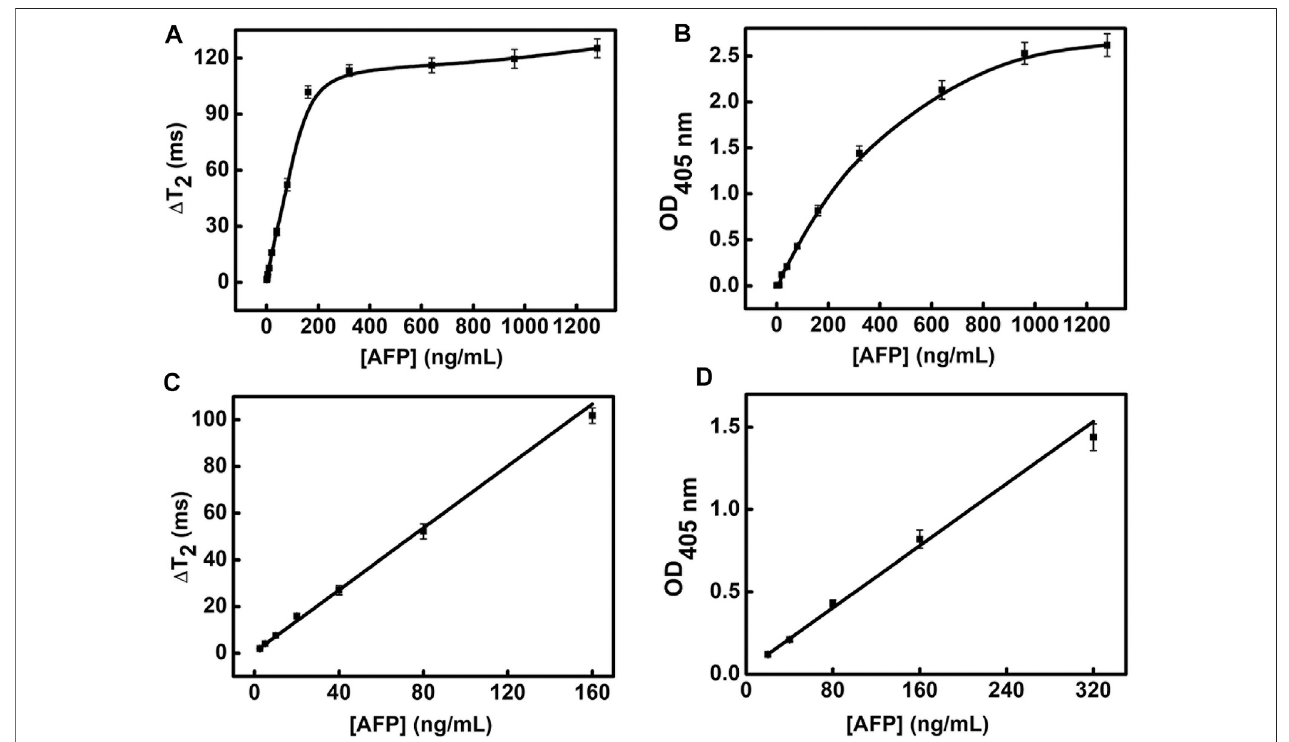
FIGURE 6 | The sensitivity of MRS sensor and pNPP-based ELISA for detecting AFP. (A) The detection range of MRS sensor for detecting AFP. (B) The detection range of pNPP-based ELISA for detecting AFP. (C) The linear range of MRS sensor for detecting AFP. (D) The linear range of pNPP-based ELISA for detecting AFP.